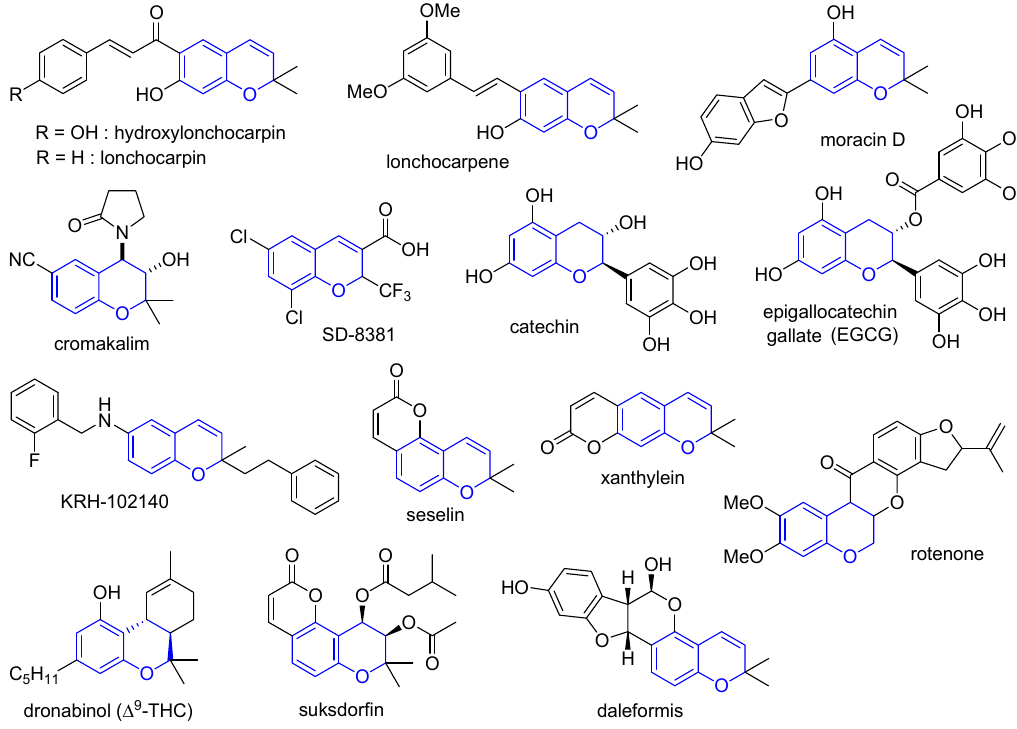
Figure 1. The representative examples of benzopyran-containing natural products